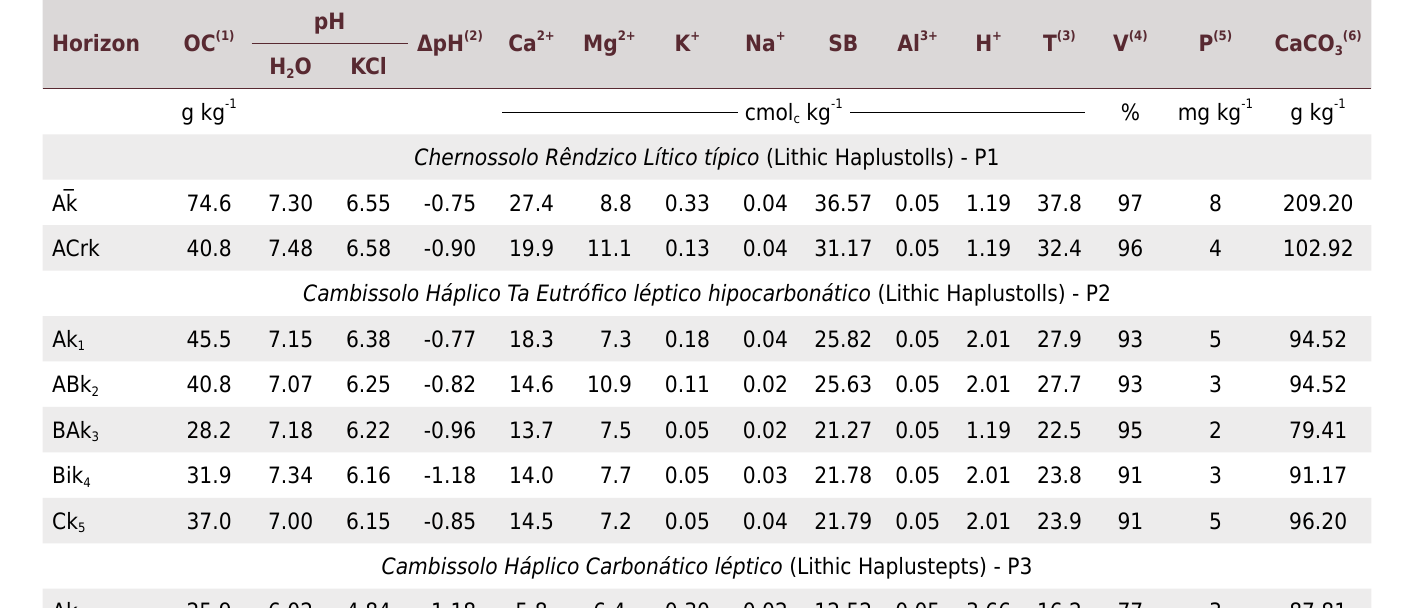
Table 4. Chemical properties of soil profiles in a toposequence in Lavandeira, TO, Brazil Horizon